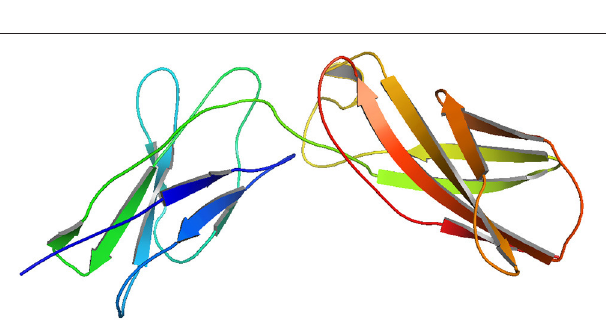
FIGURE 2 | I-Tasser generated molecular model of IL10RA.